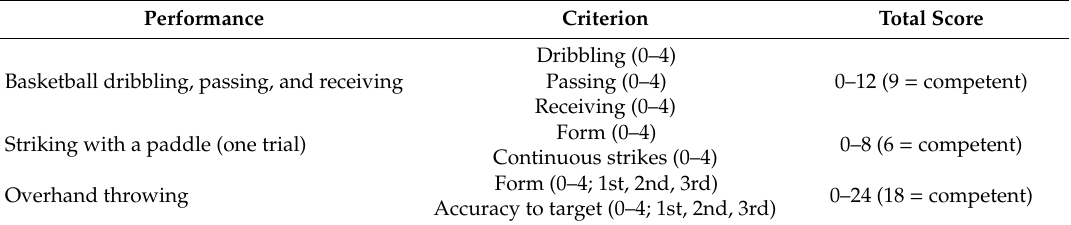
Table 1. A score range for each criterion and total score of three object control skills in physical education (PE). Performance